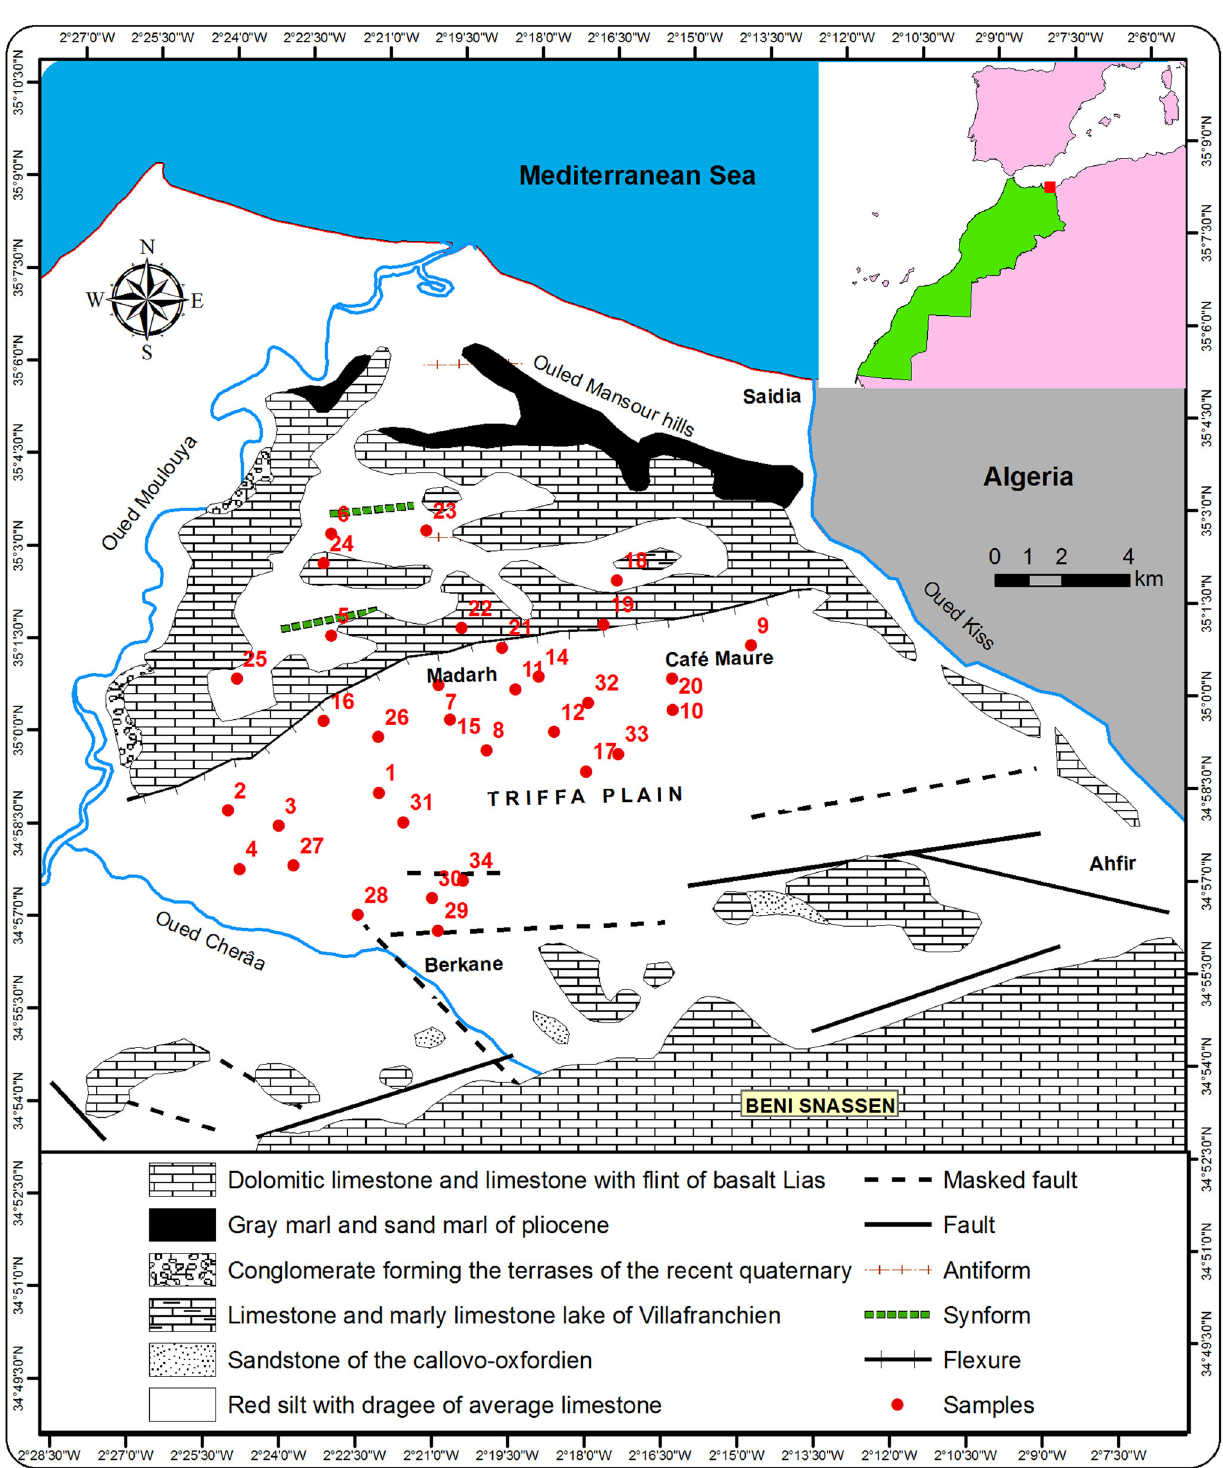
Fig. 1 Geographical and geological location of the study area (Fetouani et al. 2008), modified. Points numbered in red highlight the location of groundwater